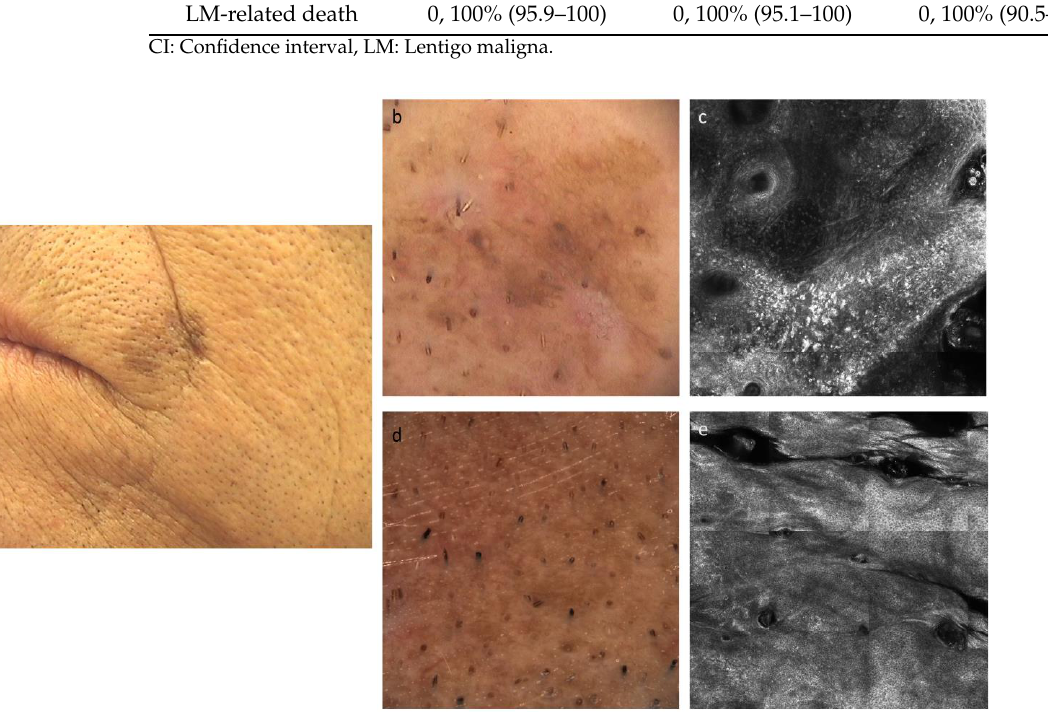
Figure 3. ( a ) Clinical images of lentigo maligna near the lip of a 69 y/o male, at the time of diagnosis. ( b ) Dermoscopic image of lentigo maligna before the therapy, which shows hyperpigmented follicular opening, with some obliterated hair follicles. ( c ) Confocal microscopy image of lentigo maligna before the therapy, which shows the loss of the epidermic architecture (disrupted honeycomb) with the presence of atypical melanocytes. ( d , e ) Dermoscopic and confocal microscopic images of the treated area, which show regular and symmetric patterns, without any signs of atypia.